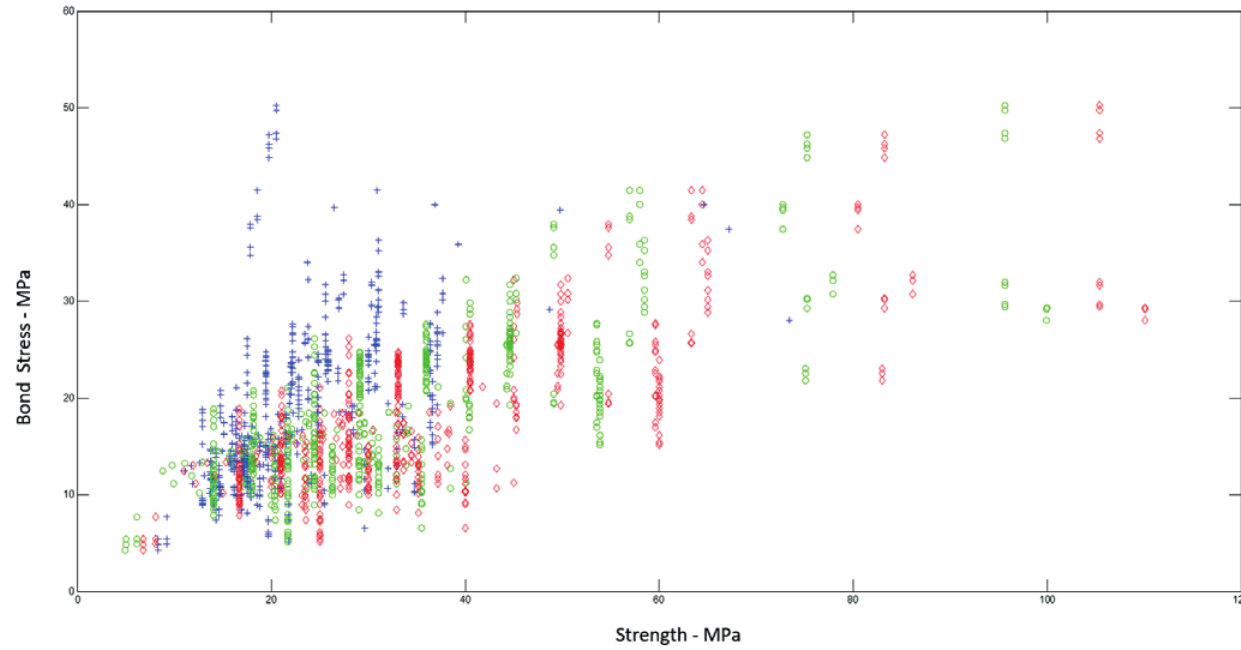
Figure 12 Artificial Neural Network modeling - ANN